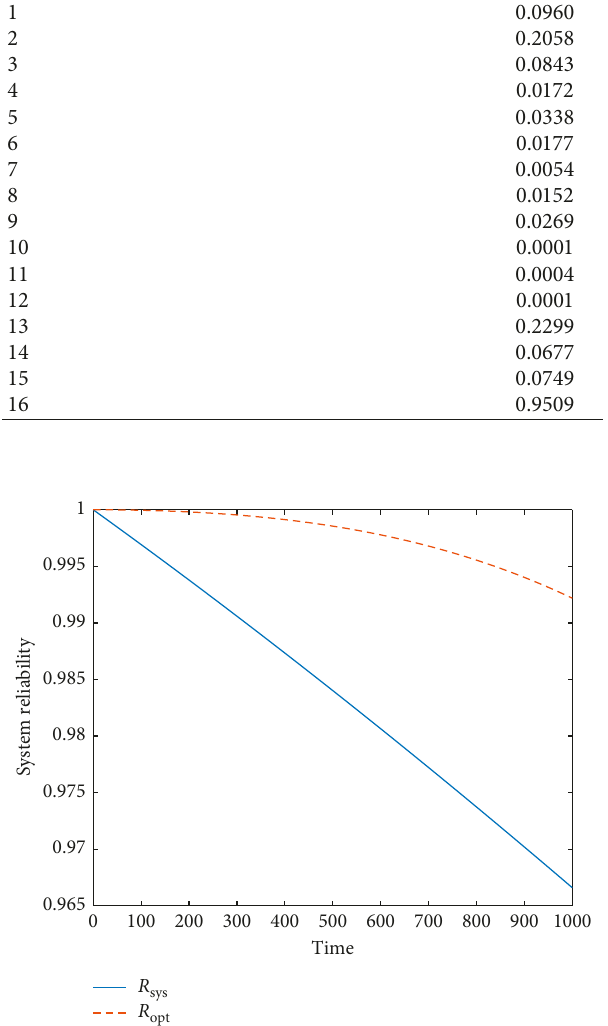
Figure 13: System reliability curves (Example 2).